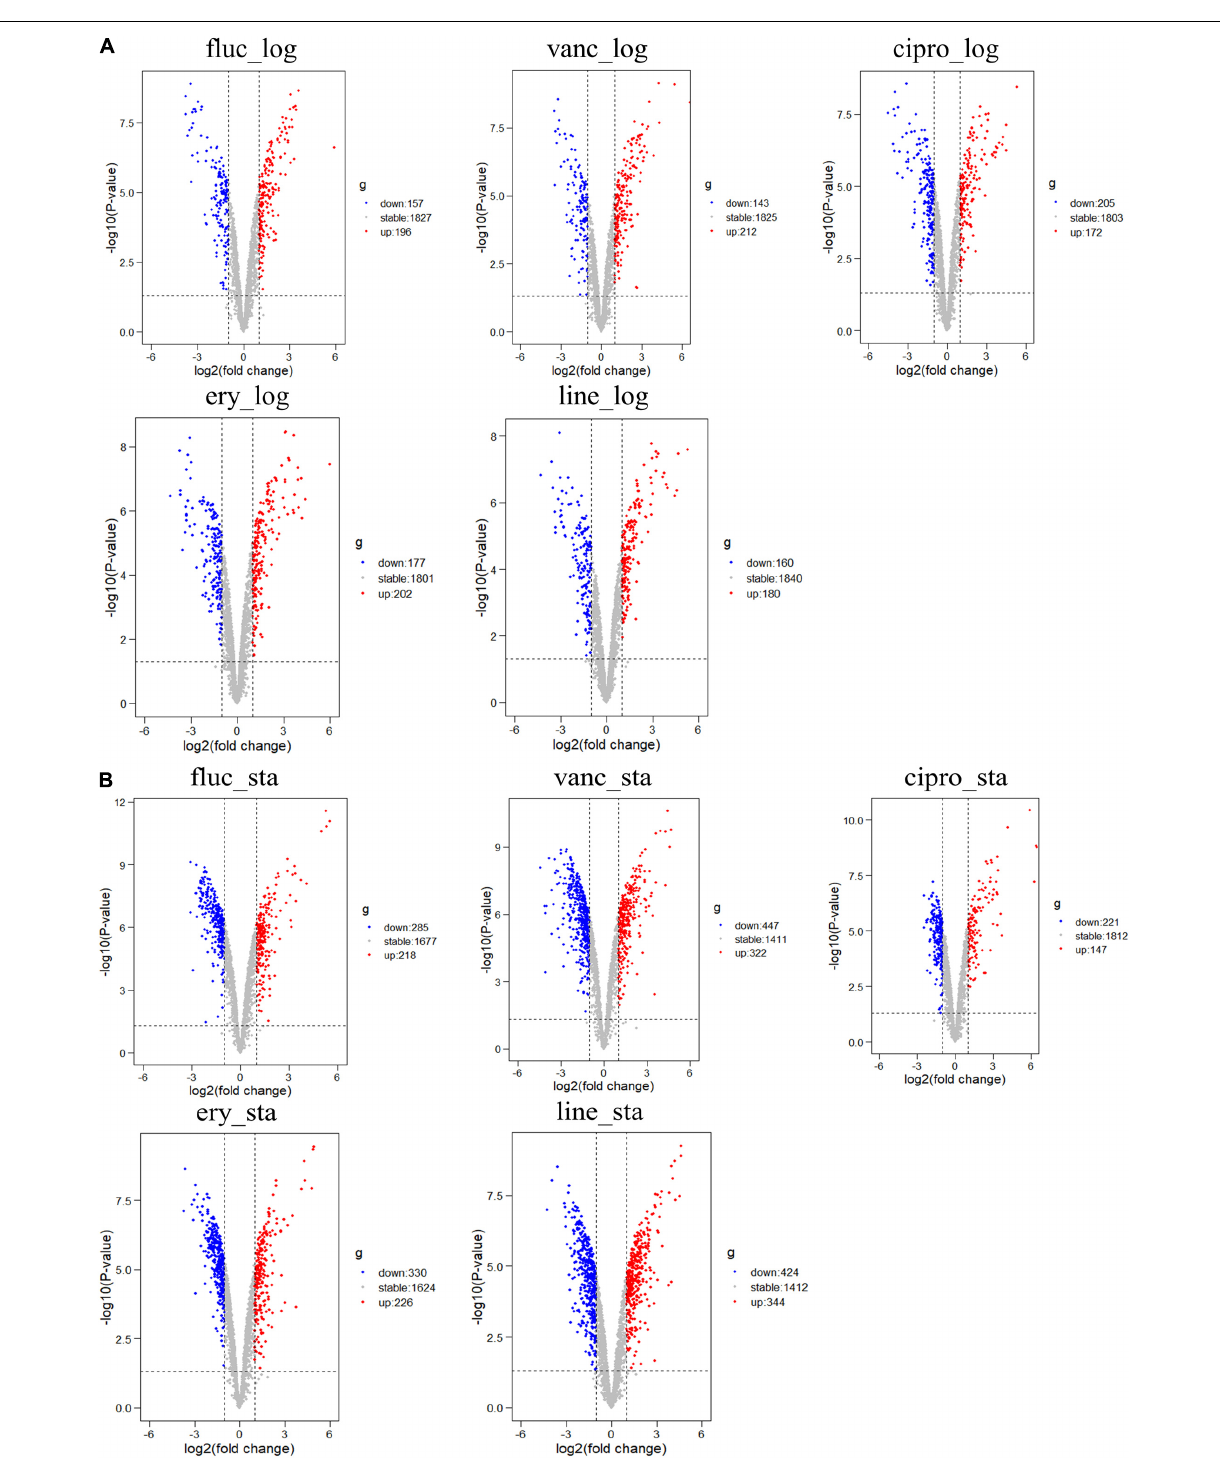
Frontiers in Microbiology |